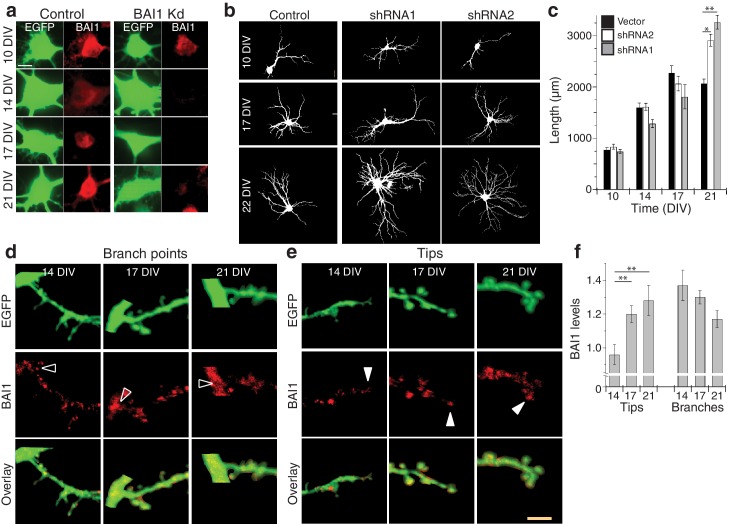
Manipulation of BAI1 leads to altered dendrite growth in fixed populations of neurons; BAI1 localizes to dendritic tips later in development.(a) Representative images of hippocampal neuronal somata from control and BAI1 Kd neurons fixed at the indicated times and stained for BAI1. Bar is 5 µm. (b) Representative somatodendritic domains from EGFP-expressing hippocampal neurons from control conditions or neurons transfected with either of the shRNAs against BAI1 from Figure 1 and Figure 1—figure supplement 1 on 7 DIV and fixed at the indicated times. Images are masked to remove axons and dendrites from other neurons. Bar is 10 µm. (c) Summary data of dendrite length. Total number of neurons: 40 for all conditions on 10 DIV; 48, 50, and 46 neurons for vector, shRNA1, and shRNA2 on 14 DIV; 28, 26, 24 for these conditions on 17 DIV; and 79, 61, and 26 for these conditions on 21 DIV (N = 4). (d and e) Representative images of EGFP, immunostaining of endogenous BAI1, and colocalization of these two. Shown are regions of branch points between primary and secondary dendrites (d) and dendrite tips (e). White arrowheads show the location of tips on the BAI1 channel, while black arrowheads show the branch points. Images are masked to remove axons and dendrites from other neurons. Bar is 5 µm. (h) BAI1 levels at dendrite tips and branch points were quantified relative to average neuronal BAI1 staining (assigned a value of 1.0) at the indicated times. Total number of neurons is the same as reported in panel c. Data are represented ± s.e.m. (***p<0.0001, **p<0.01, *p<0.05) Detailed statistics are found in Figure 2—figure supplement 1—source data 1.10.7554/eLife.47566.013Figure 2—figure supplement 1—source data 1.Statistical summary for Figure 2—figure supplement 1: ANOVA and key Tukey post-hoc tests and N and n values for Figure 2—figure supplement 1 c, f.